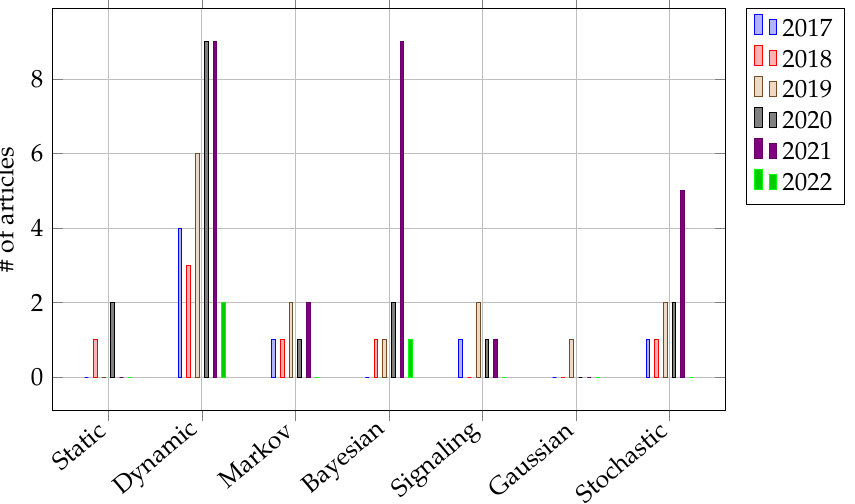
Figure 7. Publication output by year based on the game-theory process type adopted against